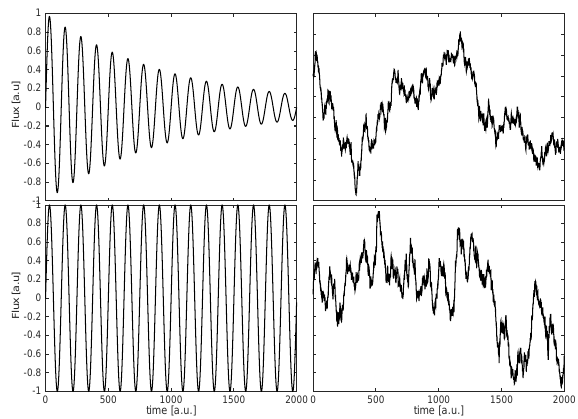
Figure 1. Synthetic light curves. A damped sinusiod (upper left) and its rednoise corrupted form (upper right); the same as above but for pure sinusoid (bottom left and right). Time and flux are given in arbitrary units.